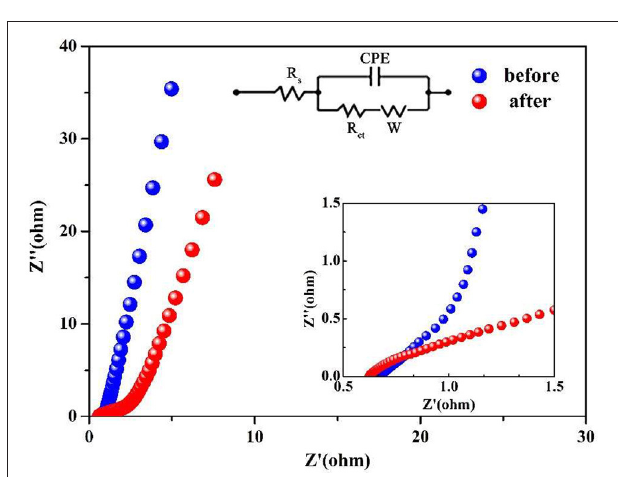
FIGURE 6 | Nyquist plots of Co 3 O 4 NWAs Electrodes before and after 25,000 cycles (inset is the enlarged view of the Nyquist diagram and equivalent circuit).